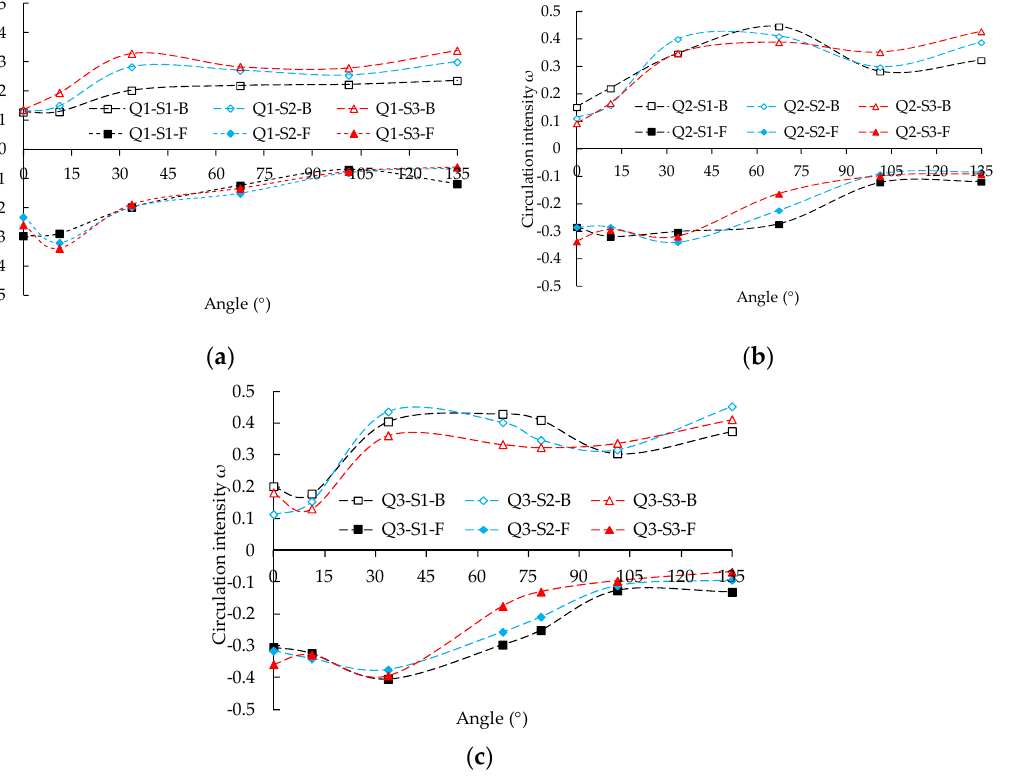
Figure 10. Variation in circulation intensity along the back bend: ( a ) Variation in circulation intensity at Q1, ( b ) Variation in circulation intensity at Q2, ( c ) Variation in circulation intensity at Q3. F of the legend denotes the RCFB in the back bend, and B of the legend denotes the CBB in the back bend.